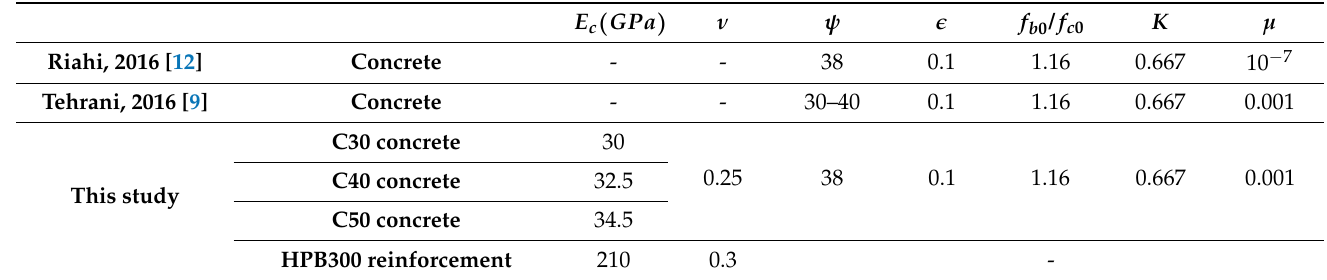
Table 3. Properties of concrete and steel materials applied in the constitutive